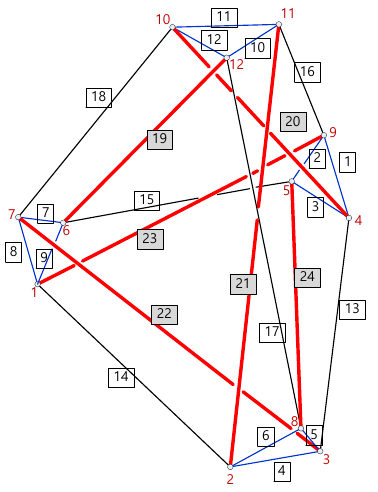
Figure 10. Connectivity of the 3D-truncated tetrahedron